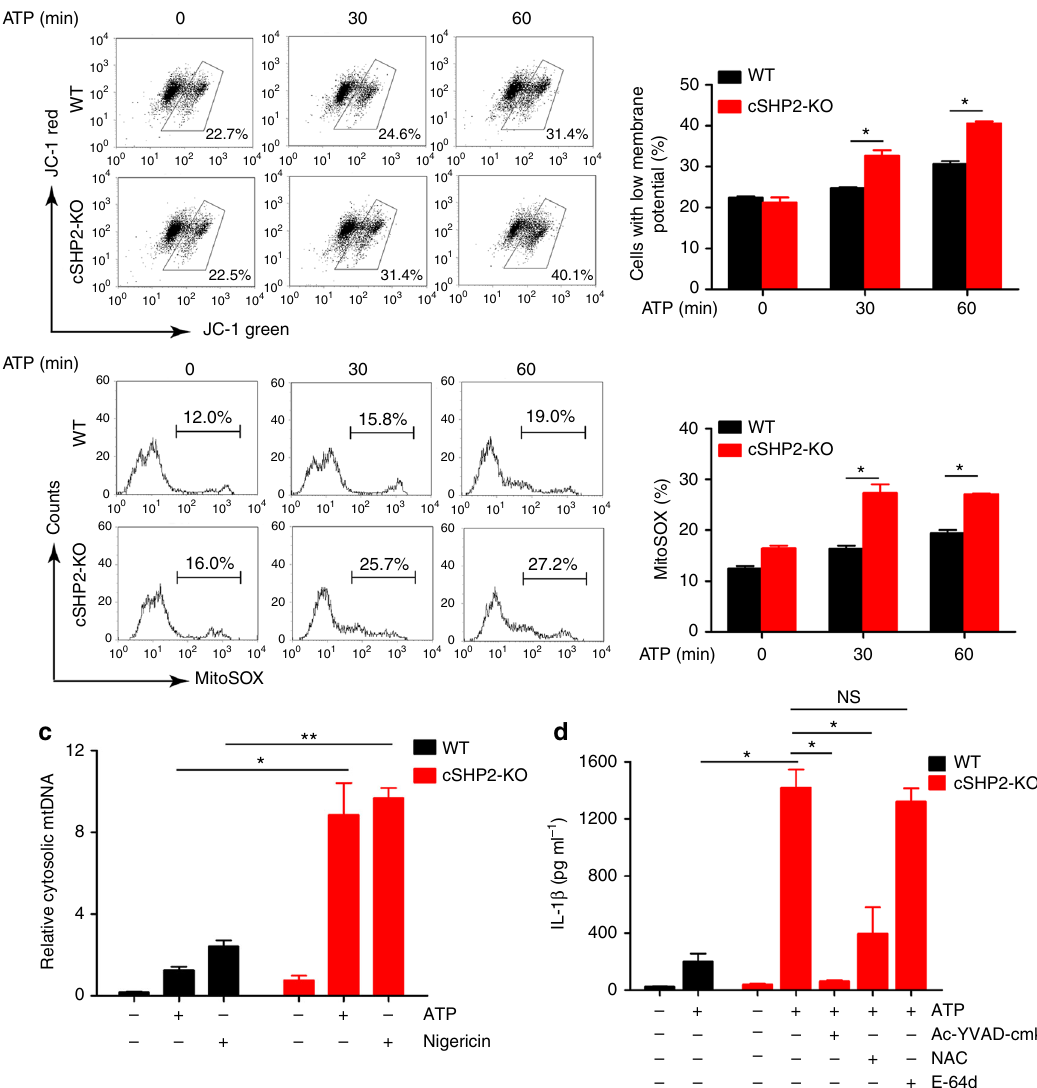
Fig. 3 SHP2 de fi ciency leads to mitochondrial dysfunction and excessive NLRP3 in fl ammasome activation. a , b Flow cytometry analysis of mitochondrial membrane potential by JC-1 staining a or mitochondrial ROS by MitoSOX staining b in peritoneal macrophages from conditional SHP2 knockout (cSHP2- KO) and wild-type (WT) mice, and left untreated or treated with ATP (5 mM) for indicated times. c Quantitative real-time PCR analysis of mtDNA released from peritoneal macrophages from cSHP2-KO and WT mice and left unstimulated (medium) or primed with LPS (100 ng ml − 1 ) for 3 h and stimulated with ATP (5 mM, 1 h) and Nigericin (10 µ M, 2 h). d ELISA of IL-1 β in supernatants of peritoneal macrophages from cSHP2-KO and WT mice, which were